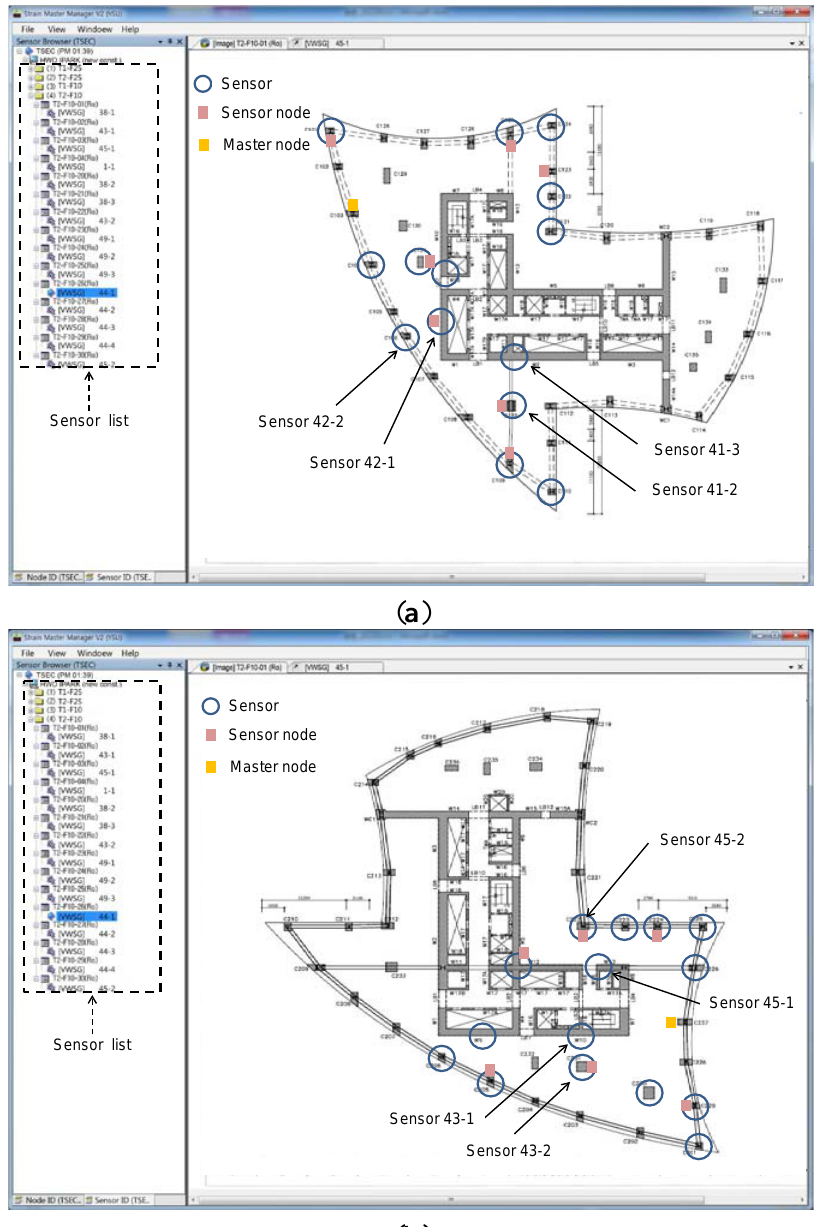
Figure 10. Location of sensors, sensor nodes, and master node installed at 10th floor